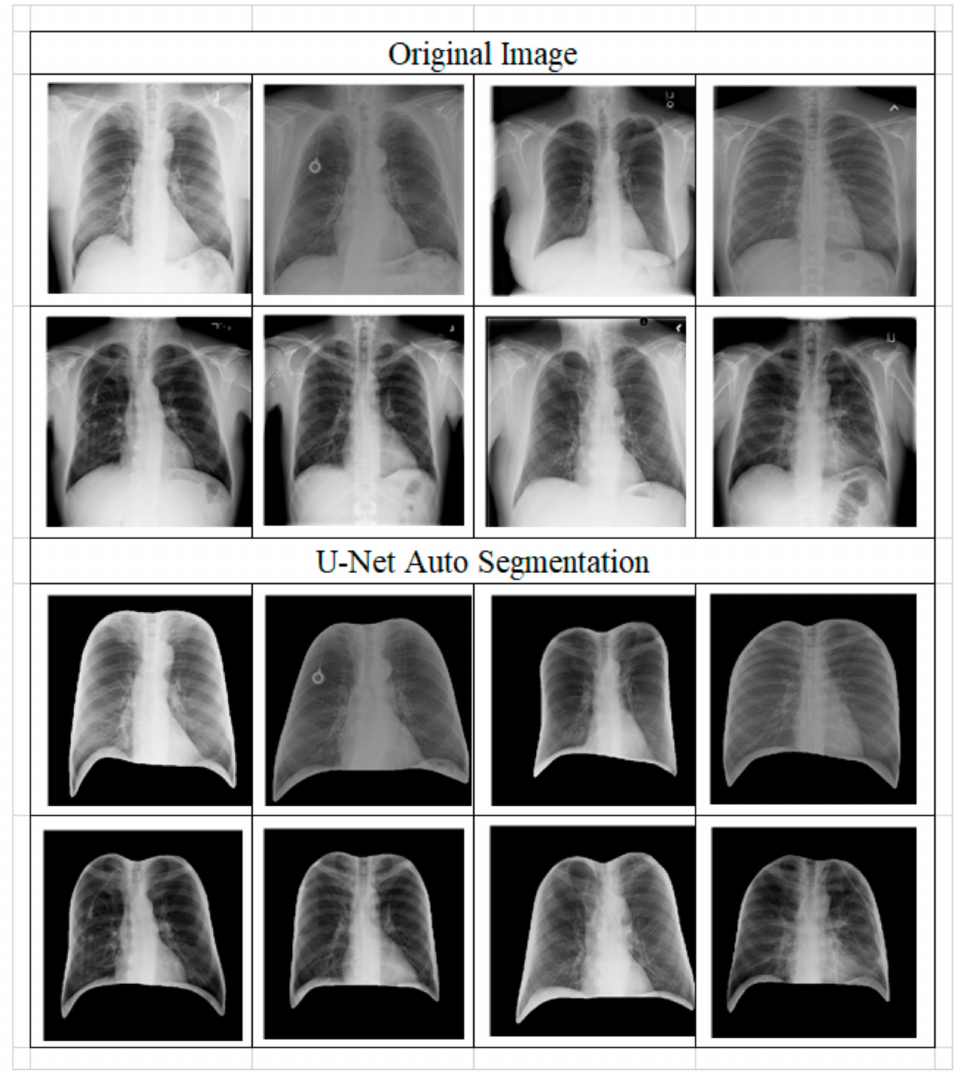
Figure 5. Images for the result of ROI preprocess by